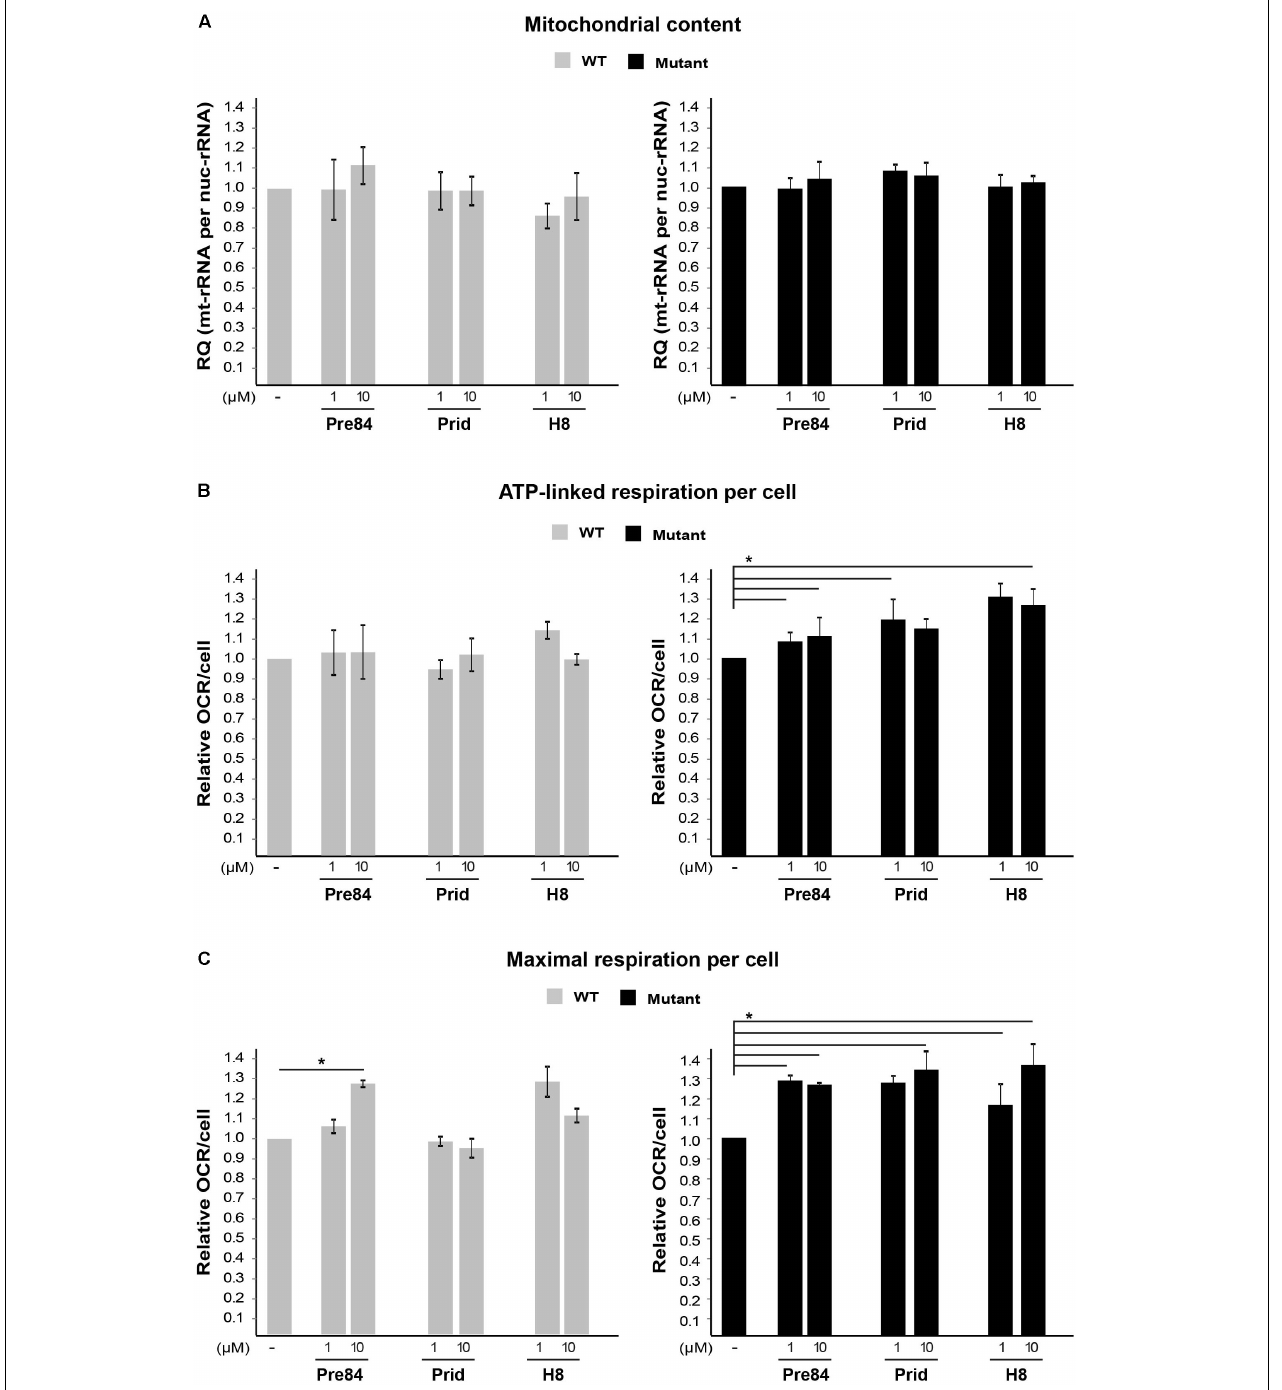
FIGURE 7 | Effect of S1R binders on mitochondria abundance and performance in astrocytes. (A) qPCR analysis of DNA encoding mitochondrial 12S rRNA and nuclear 18S rRNA in WT (gray) and Mut (black) primary astrocytes incubated or not with the indicated compounds for 6 h. Shown is average RQ of mtDNA per nucDNA values of two to six independent experiments normalized to their untreated controls ± SEM. (B,C) OCR in WT and Mut astrocytes incubated or not with the indicated compounds for 6 h. Values of ATP-linked respiration (B) and maximal respiration (C) analyzed and normalized to cell number. Shown are average values normalized to untreated cells ± SEM of six replicates in a representative experiment from four independent experiments. ∗ p < 0.05.